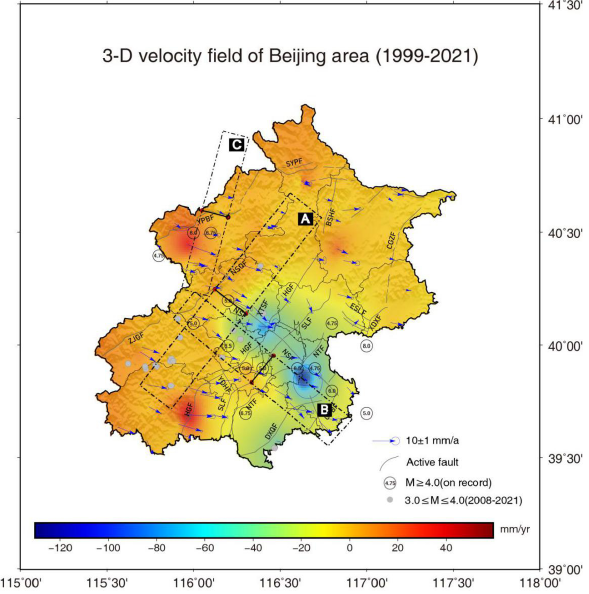
Figure 2. 3-D GNSS velocity field of Beijing area with respect to Eurasian plate. Blue arrows indicate the GNSS horizontal velocities from this study, and the vertical velocities are plotted at the background. Error ellipses represent 70% confidence. Black dash lines and the alphabet are the GNSS velocity profiles, black solid lines represent the fault relative to the velocity profile, red circle indicated the width of the profile along the